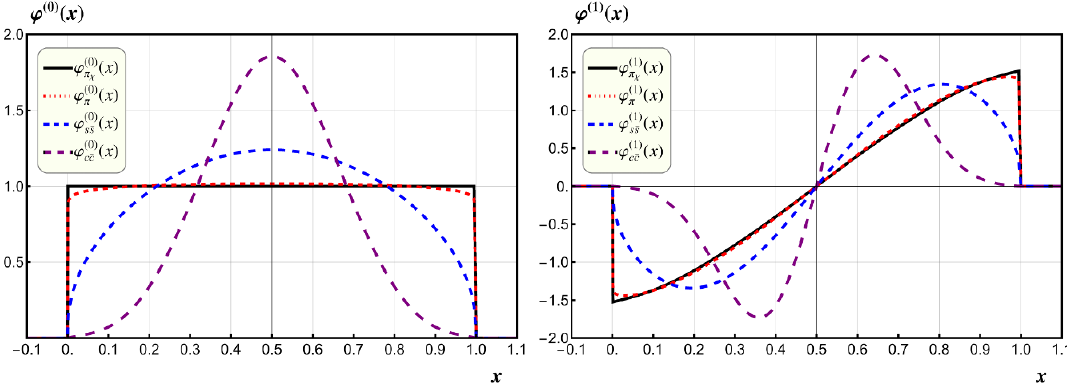
Figure 7 . The solutions to the ’t Hooft (Light-front) wave functions of ground state and the (cid:12)rst excited state mesons, for several distinct quark mass. The ground/1st-excited state LF wave functions are even/odd under charge conjugation transformation x